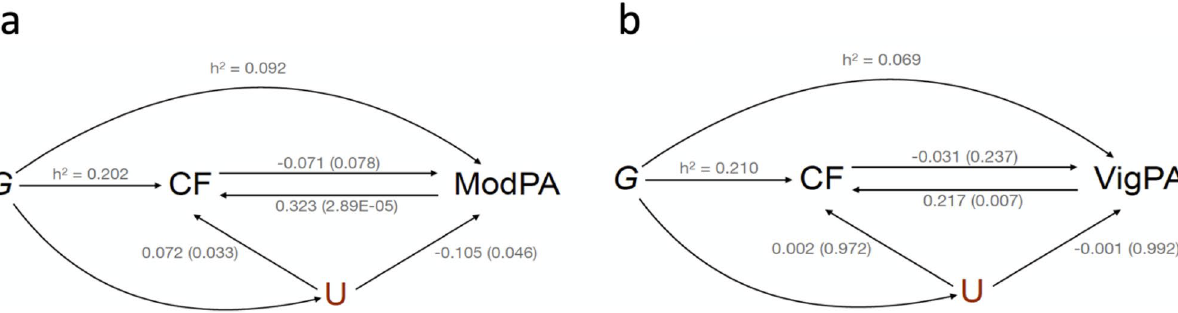
Figure 2. Visual representation of the model in Latent Heritable Confounder Mendelian Randomization (LHC-MR). G = Genetic instruments; CF = general cognitive functioning; ( a ) For moderate physical activity (ModPA); ( b ) For vigorous physical activity (VigPA); U = Latent heritable confounder; h 2 = direct heritability.